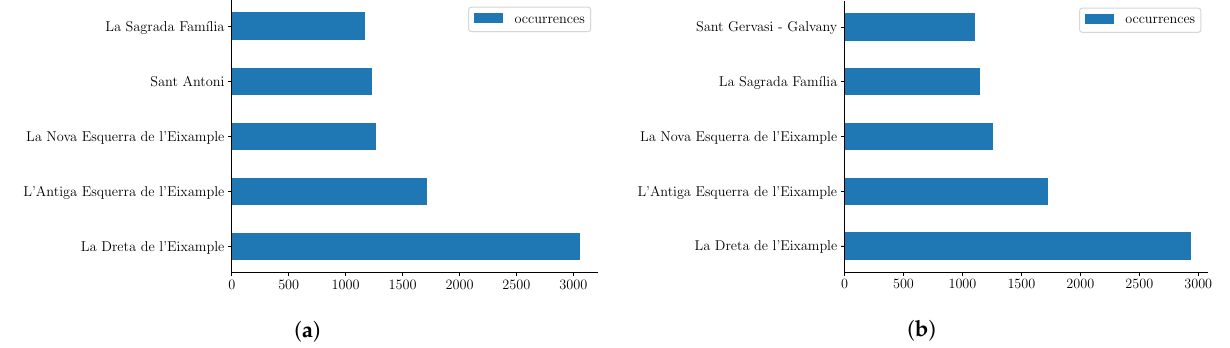
Figure 6. Five most frequent neighborhoods: ( a ) Starting points per neighborhood; ( b ) Finishing points per